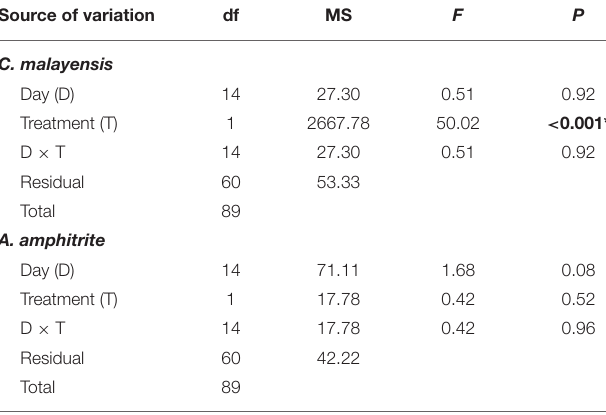
TABLE 5 | Two-way ANOVA on the effects of treatment and day on the percentage of surviving barnacles in the submergence experiment. Source of